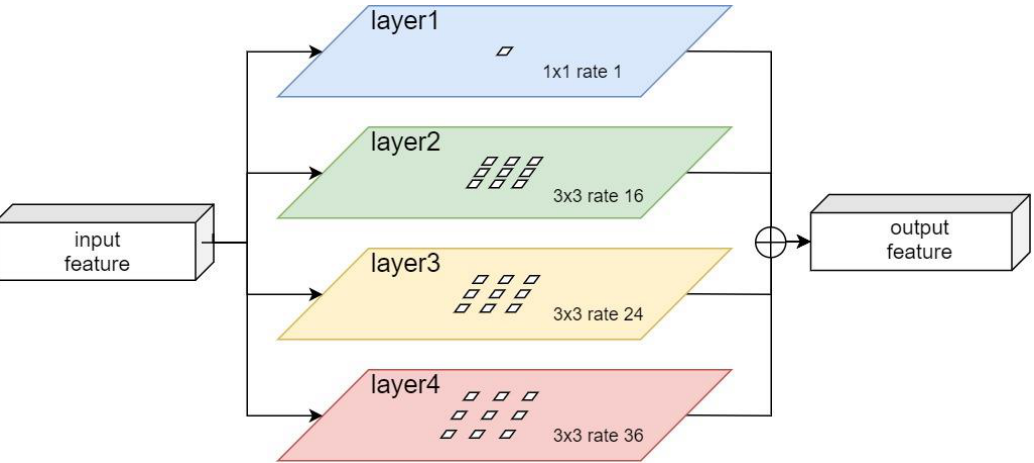
Figure 8. The illustration of the ASPP block, in which ‘ ⊕ ’ denotes the concatenate